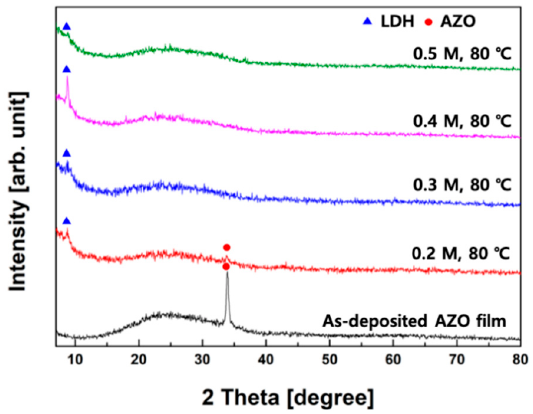
Figure 3. X ‐ ray diffraction (XRD) patterns of AZO thin film and Zn ‐ Al LDH with different molar Figure 3. X-ray di ff raction (XRD) patterns of AZO thin film and Zn-Al LDH with di ff erent concentrations. molar